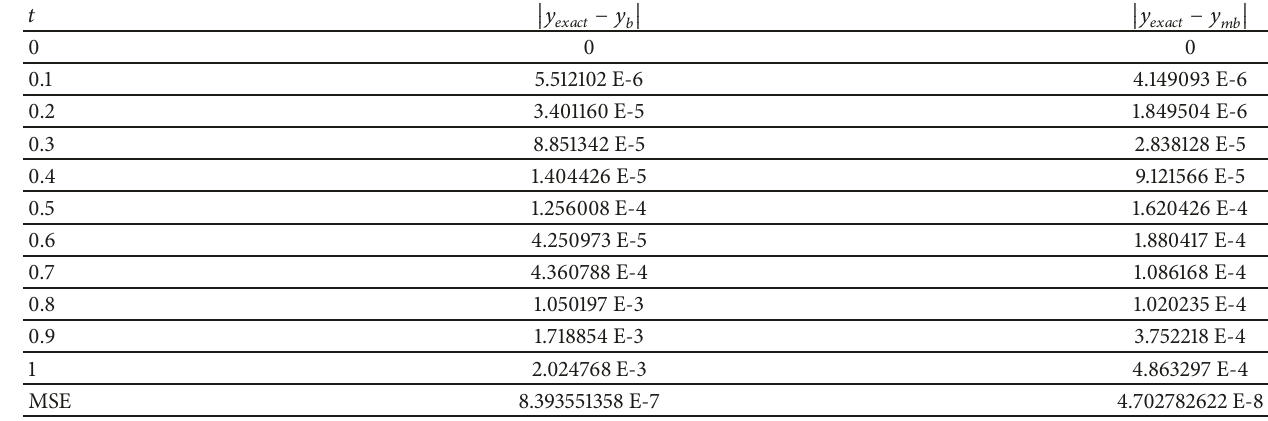
Table 4: Comparison of absolute errors using 𝑦 6 when m=v=6, k=2, and x=0.1.